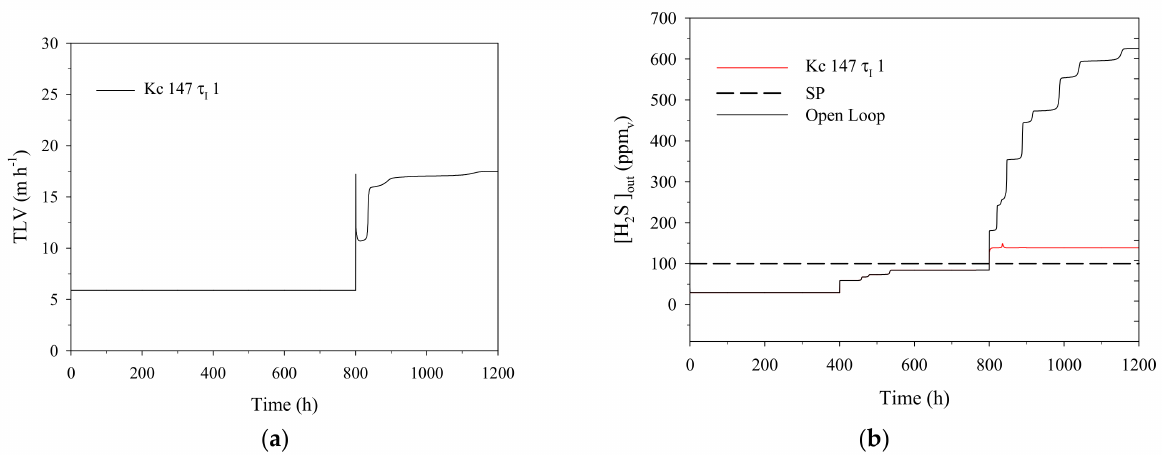
Figure 7. TLV-CL results obtained for the scenario with H 2 S control facing inlet H 2 S concentration changes using a PI controller. ( a ) Trickling liquid velocity (manipulated variable) and ( b ) H 2 S outlet concentration (controlled variable) compared to the Open-Loop